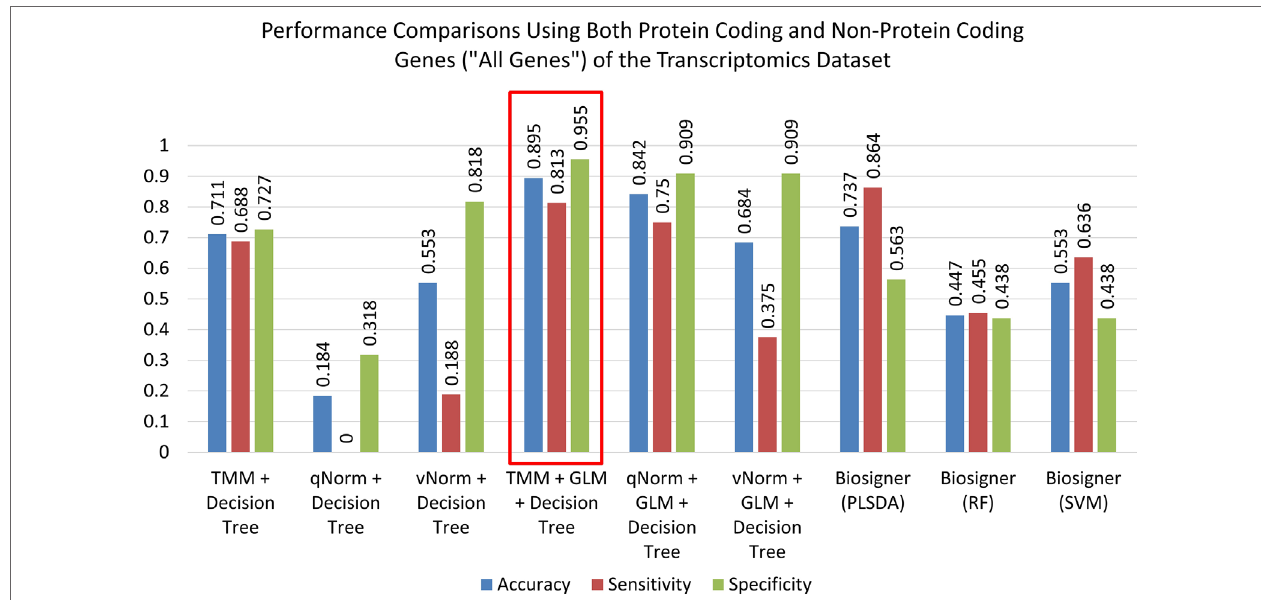
FIGURE 3 | Performance comparisons using both protein-coding and nonprotein-coding genes (“all genes”) of the transcriptomics